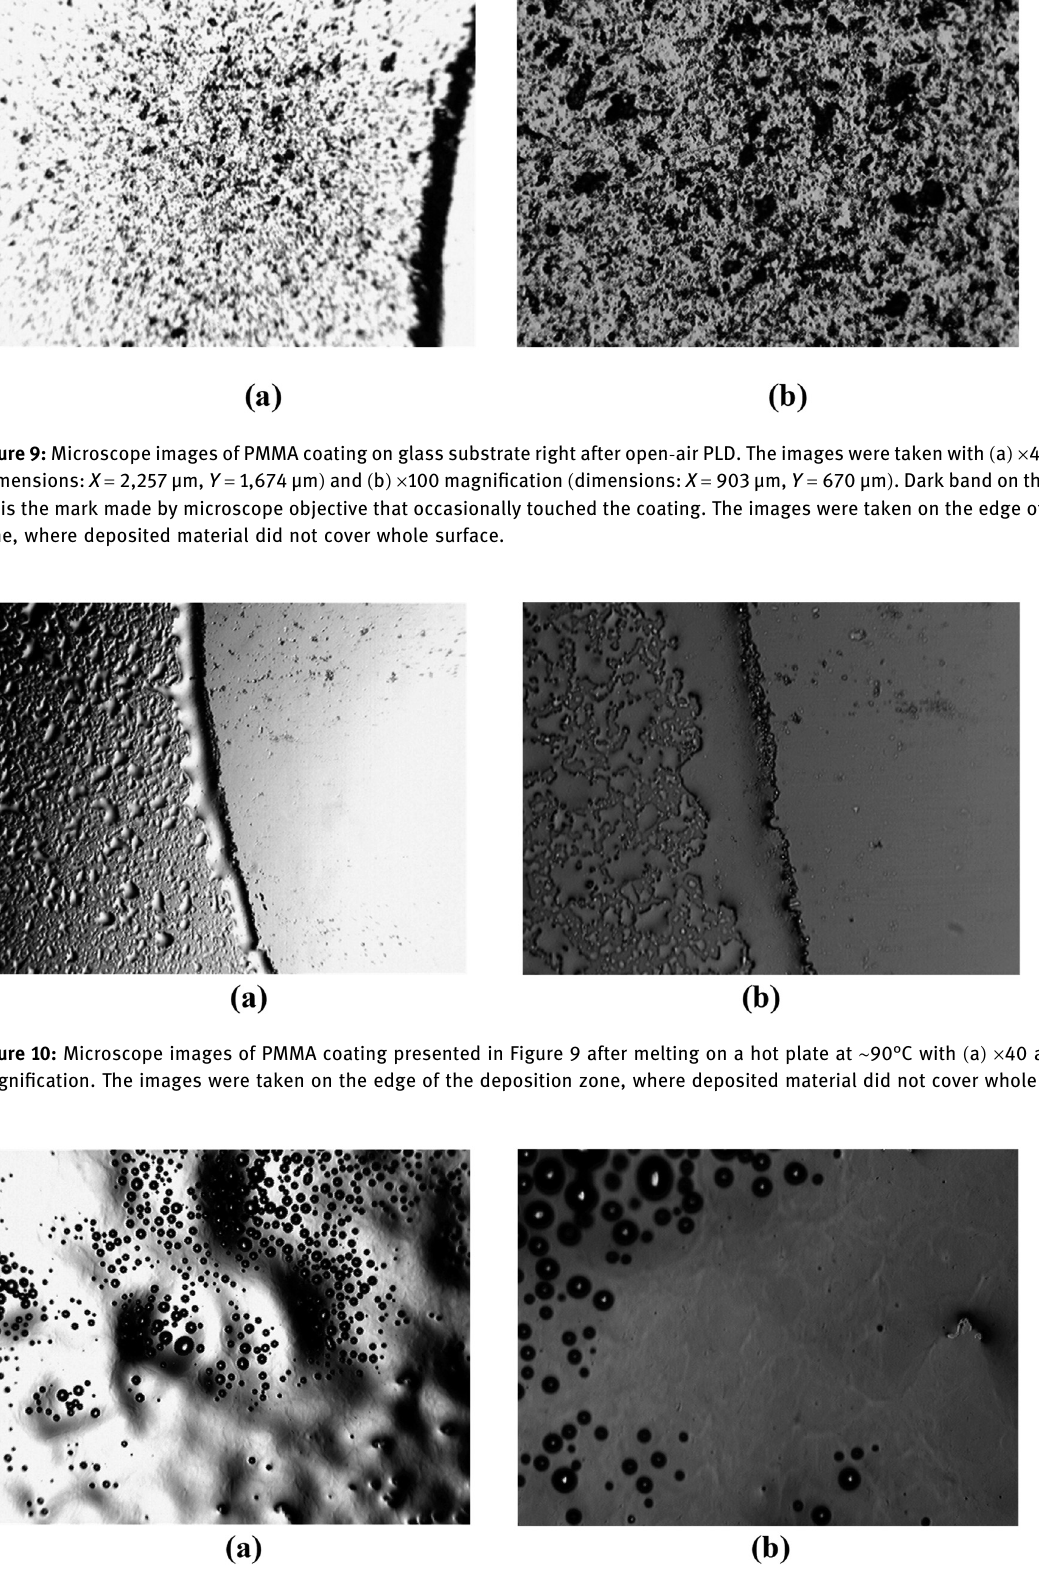
Figure 11: Microscope image of PMMA coating right after melting on a hot plate at ∼ 90°C taken with ( a ) × 40 and ( b ) × 100 magni fi cation. The images were taken in the centre, where deposited material covered whole surface. Small circles are air bubbles in the boiling